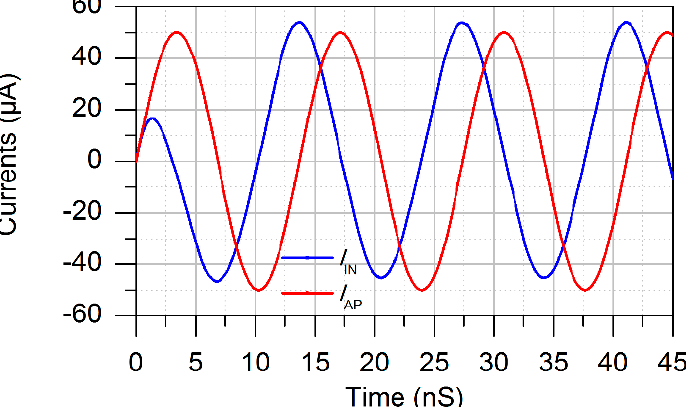
Figure 7. Differential input current and differential AP output current at 73 MHz.